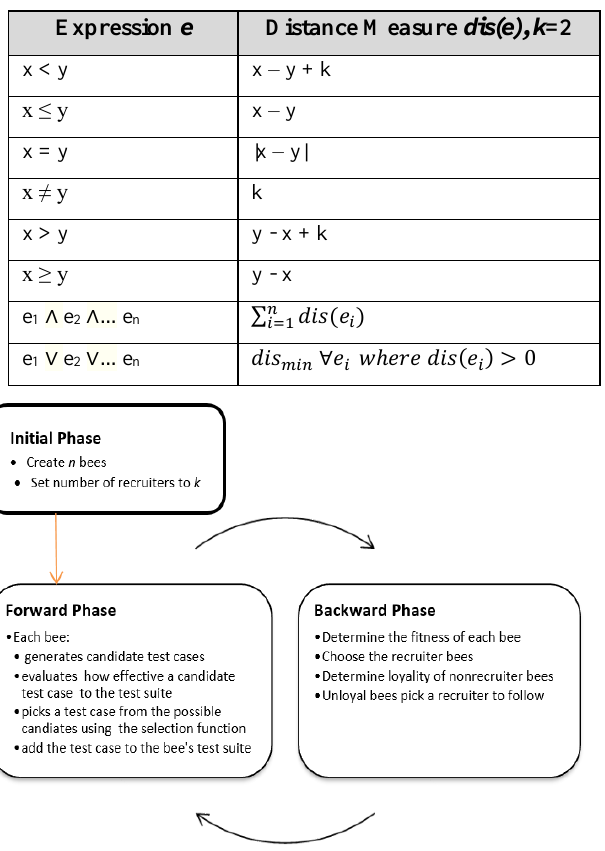
Table 1. How the dis(C i ) value is computed Expression e